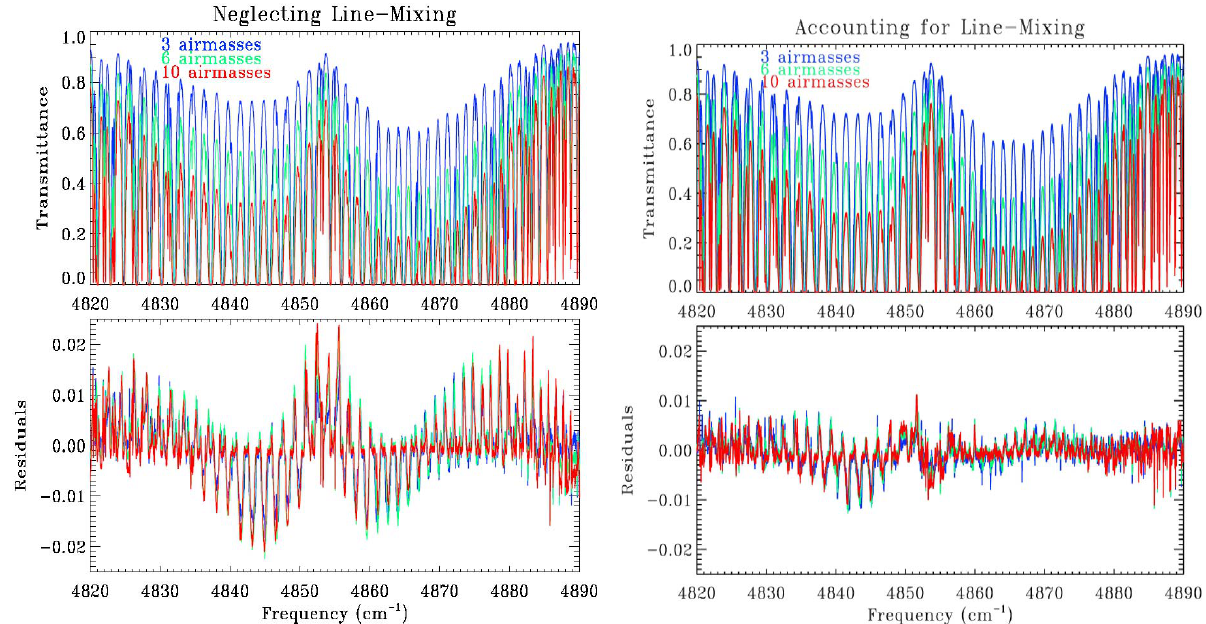
Figure 8. Residuals obtained from fits of ground-based atmospheric solar-absorption spectra in Band#1 for various airmasses. The panels on the left and right hand sides display results obtained without and with the inclusion of LM, respectively.